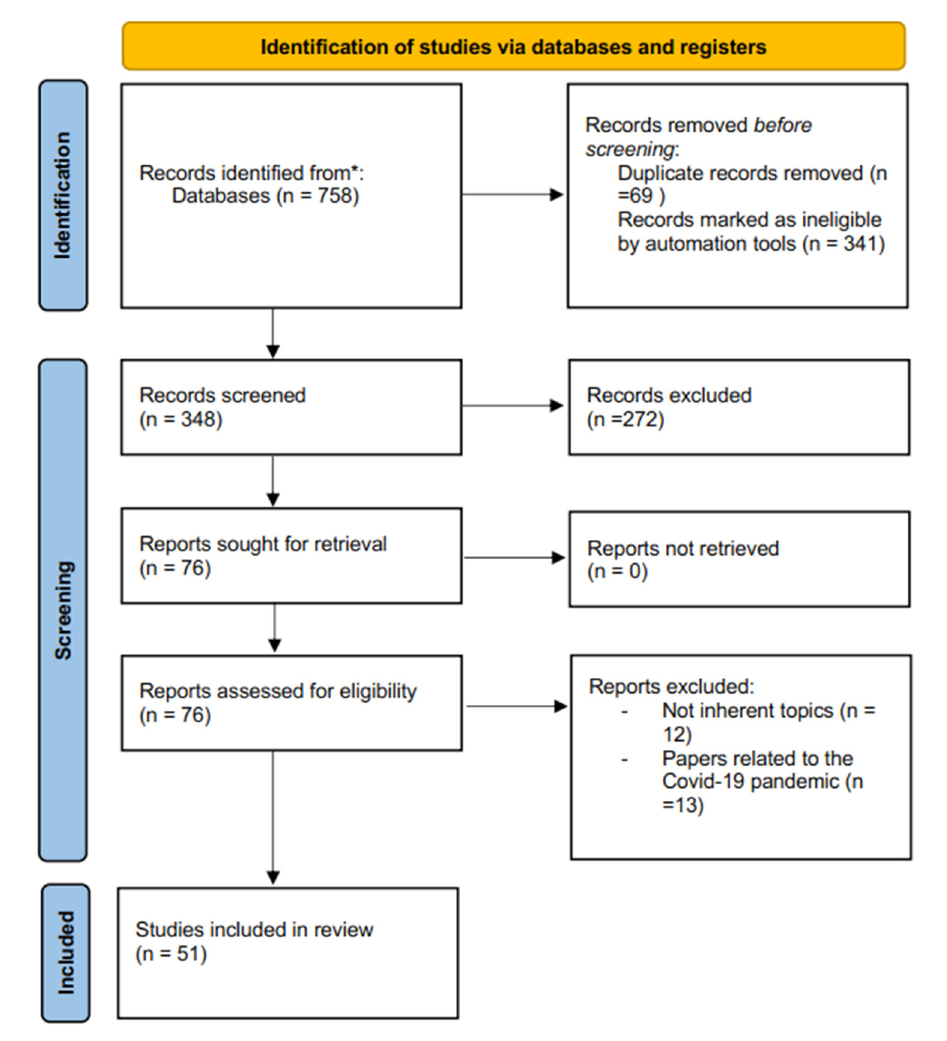
Figure 1. PRISMA 2020 flow diagram for new systematic reviews, which included searches of databases and registers only.